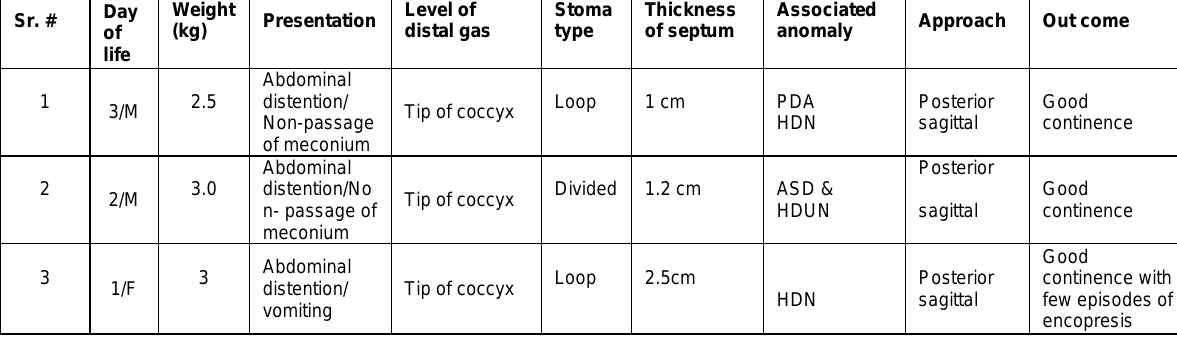
Table 1: Clinical characteristics of three patients